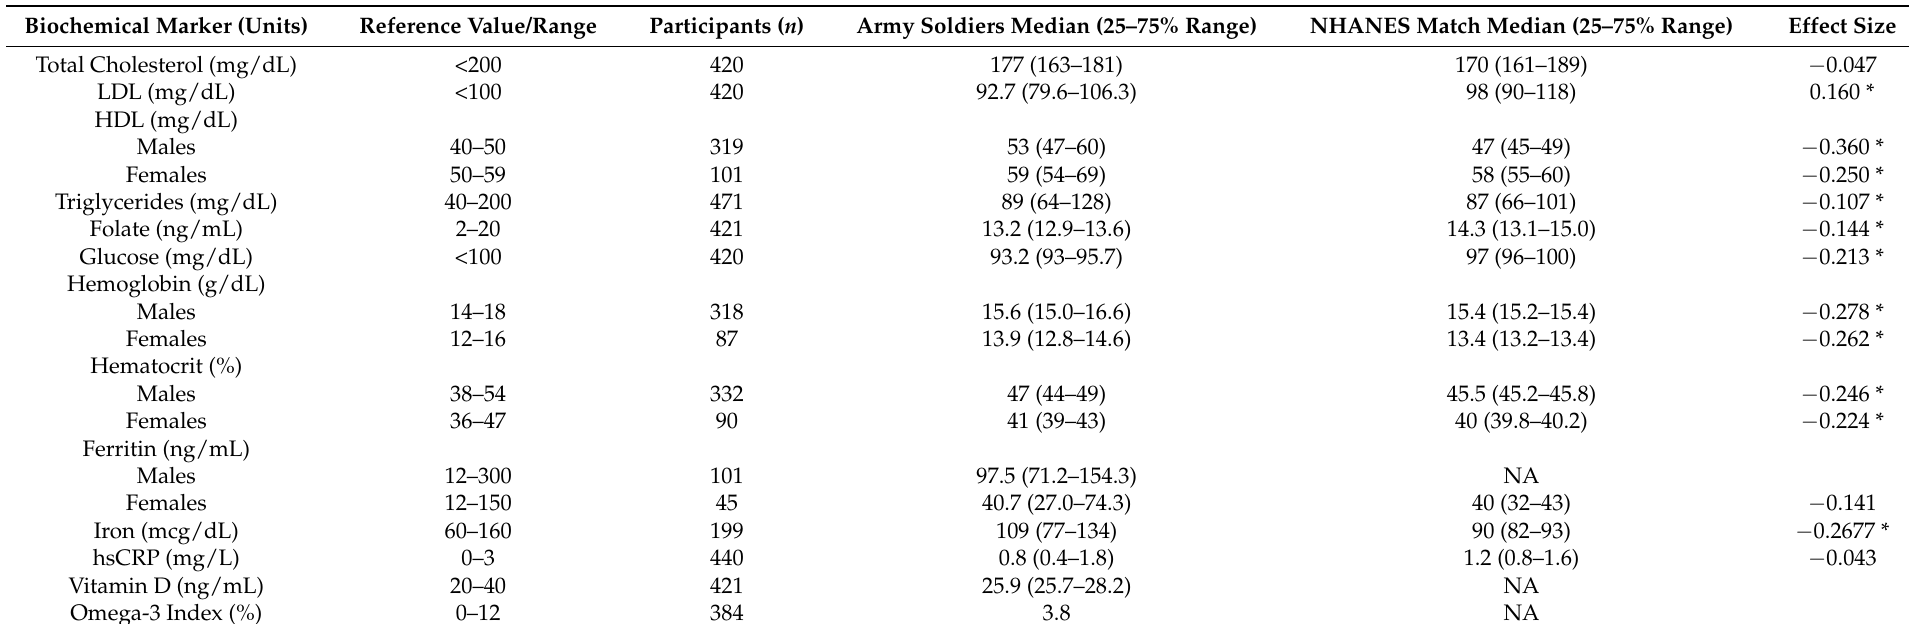
Table A1. Comparison of biochemical marker results between soldiers and a civilian control group (NHANES